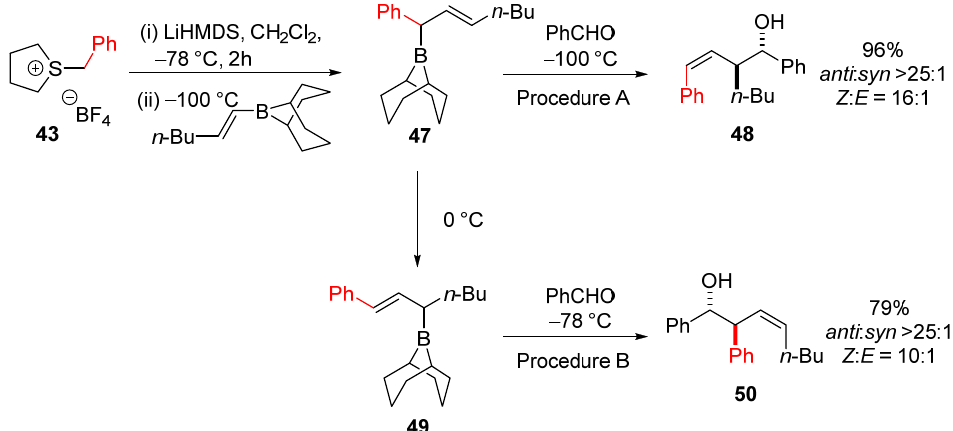
30 Table 16. Scope of homologation reactions involving 9-BBN derivatives (Scheme 56).